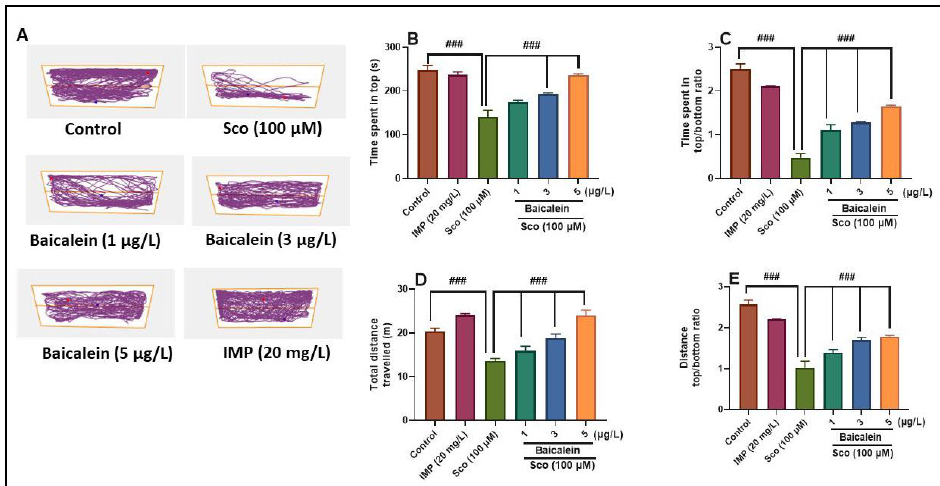
Figure 1. Effects of the baicalein 5,6-dimethyl ether (1, 3, and 5 µg/L) on scopolamine (Sco, 100 μM)-induced anxiety-like behavior in the novel tank-diving test (NTT). ( A ) representative swimming tracks of zebrafish in each group; ( B ) the time spent in top (s) in each group; ( C ) time spent in top/bottom ratio in each group; ( D ) total distance travelled (m) in each group; ( E ) distance top/bottom ratio in each group. Values are means ± S.E.M. ( n = 10). For Tukey’s post hoc analyses: Control vs. Sco: ### p < 0.0001, Sco vs. Baicalein 5,6-dimethyl ether (1, 3, and 5 µg/L): ### p < 0.0001 (B, C, D, and E).